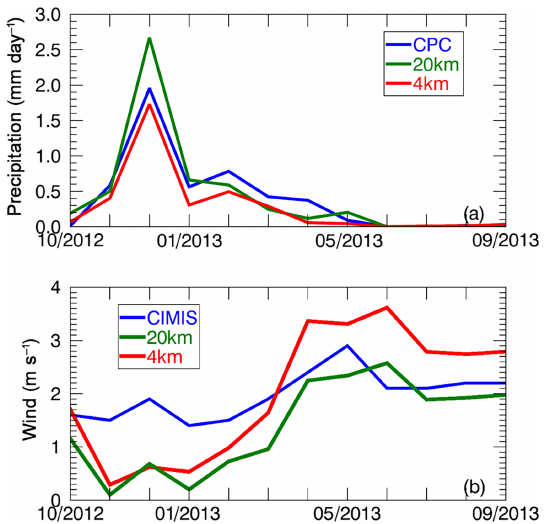
Figure 2. (a) Monthly precipitation (mmday − 1 ) from CPC, 20km and 4km; (b) monthly wind speed (ms − 1 ) from CIMIS, 20km and 4km. 4km_D2 (not shown) is similar to 4km.